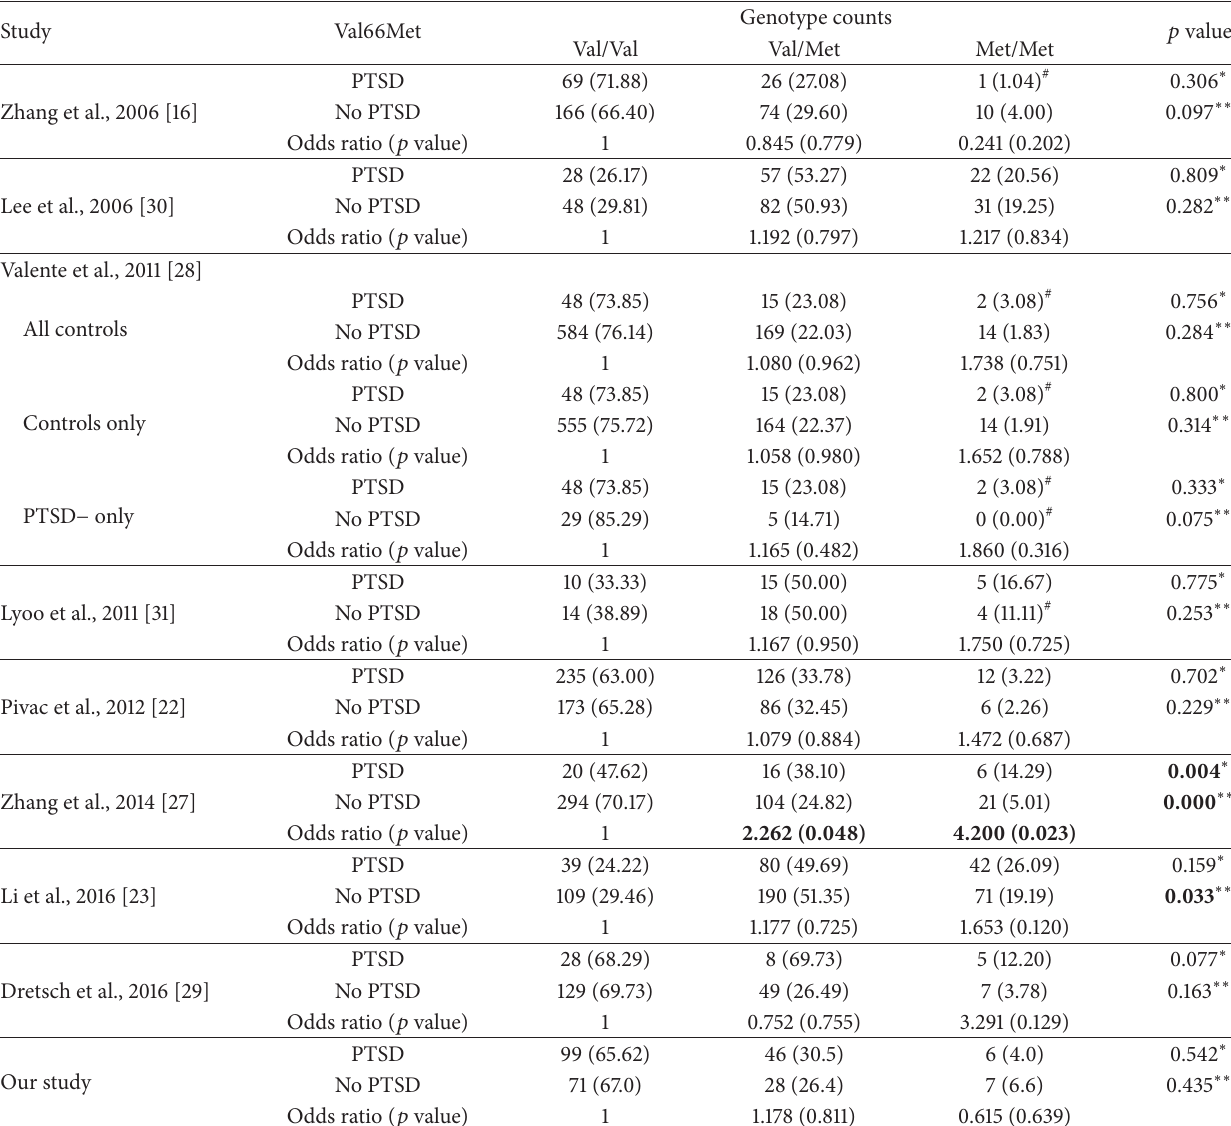
Table 4: Individual studies with their respective odds ratios and 95% confidence